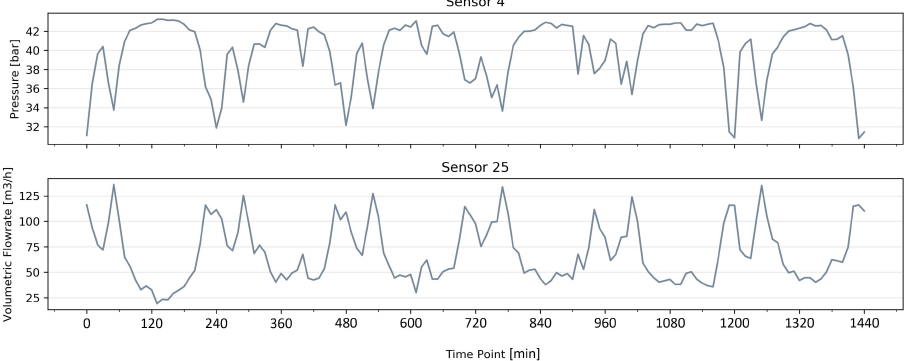
Figure 6. Synthetic time series of sensors 4 and 25 from chunk